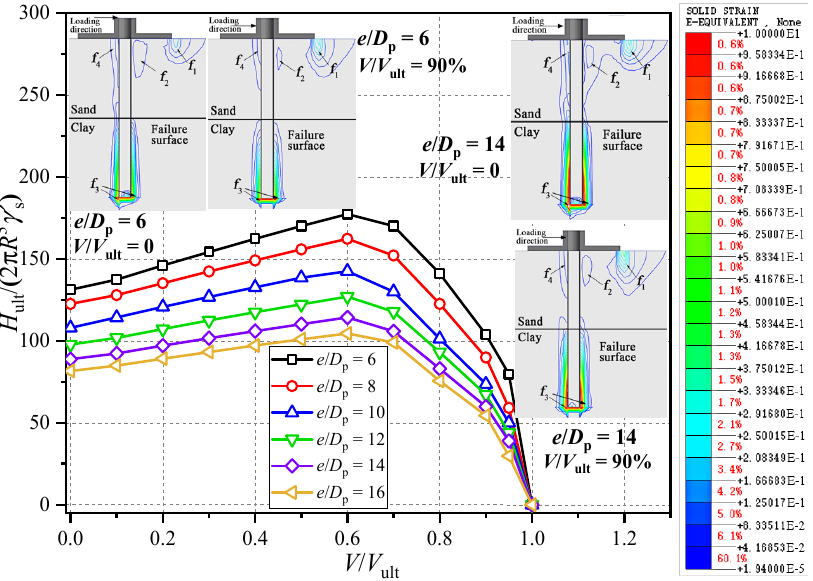
Figure 5. Effect of the pre-vertical loading on the lateral capacity and the failure mechanism with different loading height.